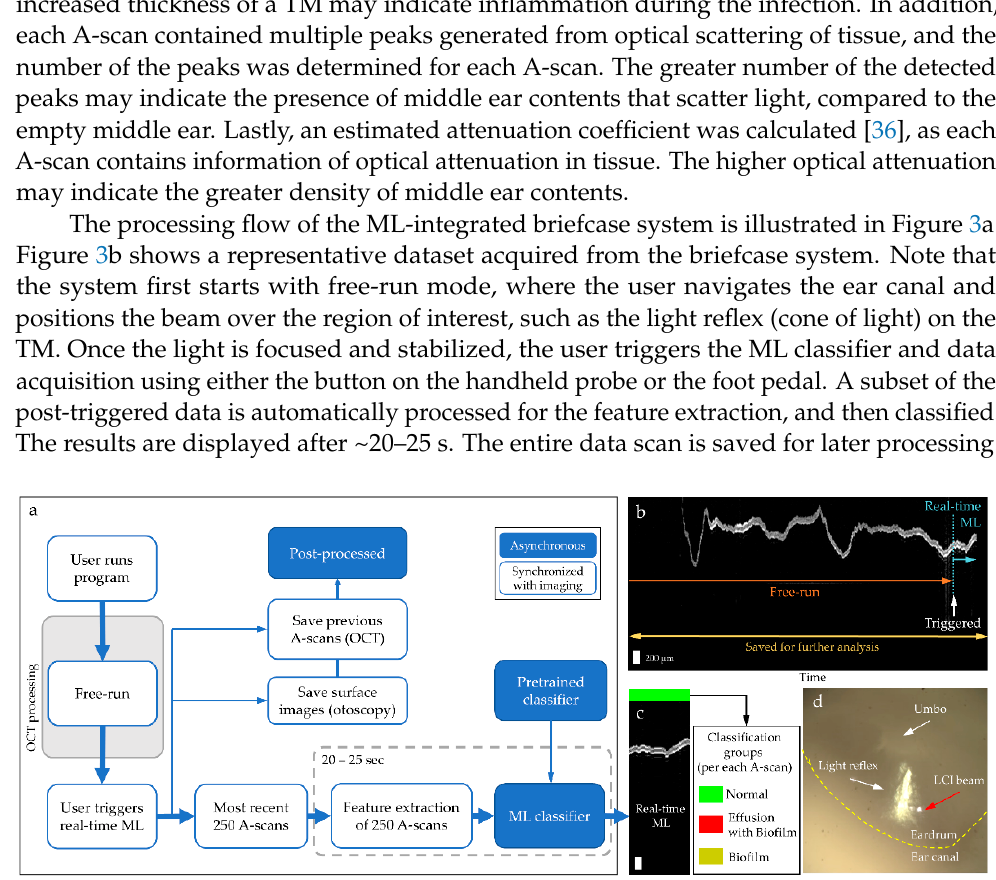
Figure 3. Processing flow and representative output of the ML-integrated briefcase system. ( a ) Step- by-step illustration of image acquisition, processing and feeding to the ML classifier; ( b ) representa- tive OCT image showing complete dataset: during free-run and the post-triggered data (250 A-scans) sent to the real-time ML classifier; ( c ) output display of the classifier; ( d ) simultaneously acquired surface image of the TM labeled with major anatomical landmarks.